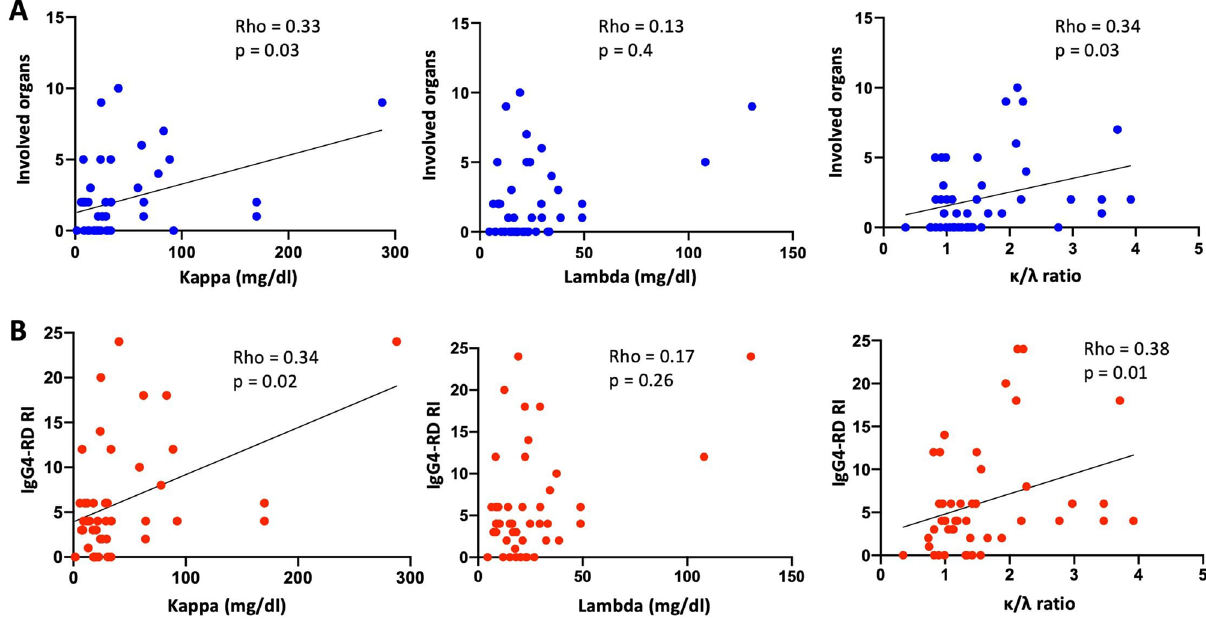
Figure 4. Relationship between κ and λ serum free light chains and the κ/λ ratio and clinical parameters in the IgG4-related disease patients (n = 45). ( A ) Correlation between the number of involved organs and the levels of κ and λ serum free light chains and the κ/λ ratio. ( B ) Correlation between the IgG4-RD RI and the levels of κ and λ serum free light chains and the κ/λ ratio. All correlations were determined using Spearman’s test. IgG4-RD RI IgG4-related disease responder